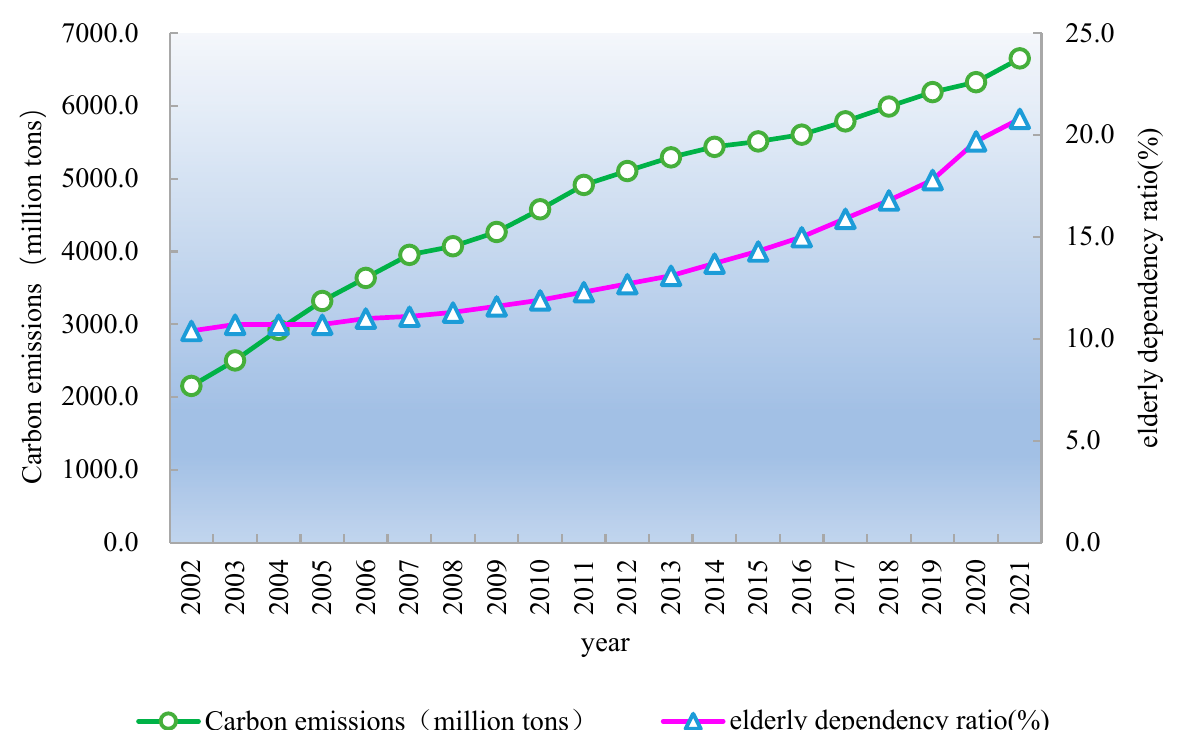
Figure 1. Carbon emissions and elderly population dependency ratio in China, 2002–2021.